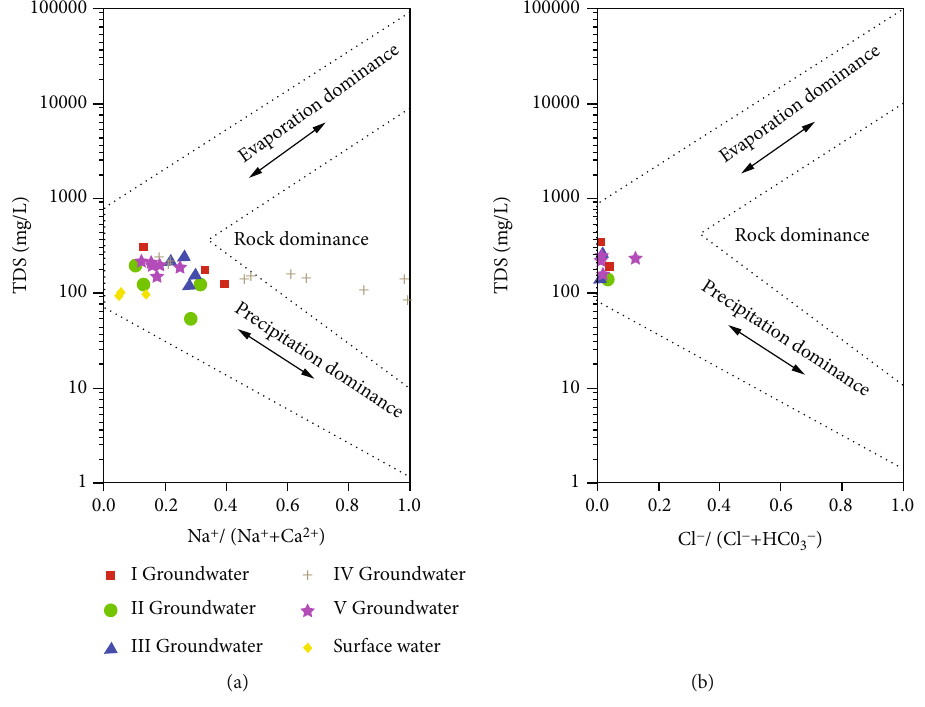
Figure 5: Gibbs model of the study